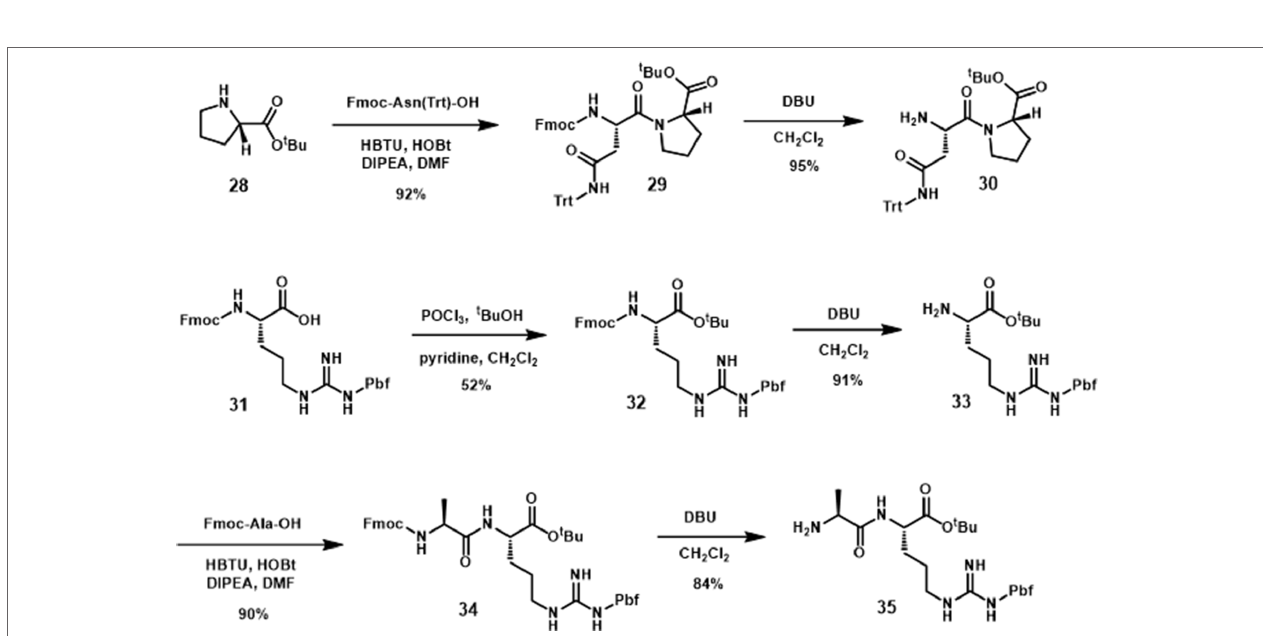
SCHEME 4 | Synthesis of dipeptides 30 and 35